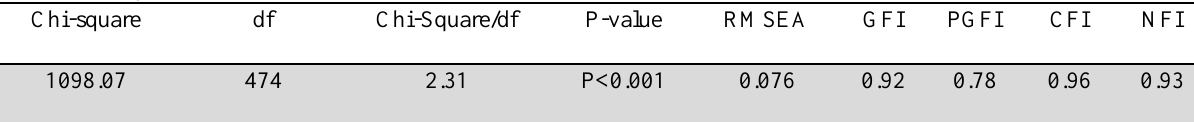
The summary of statistics on SEM